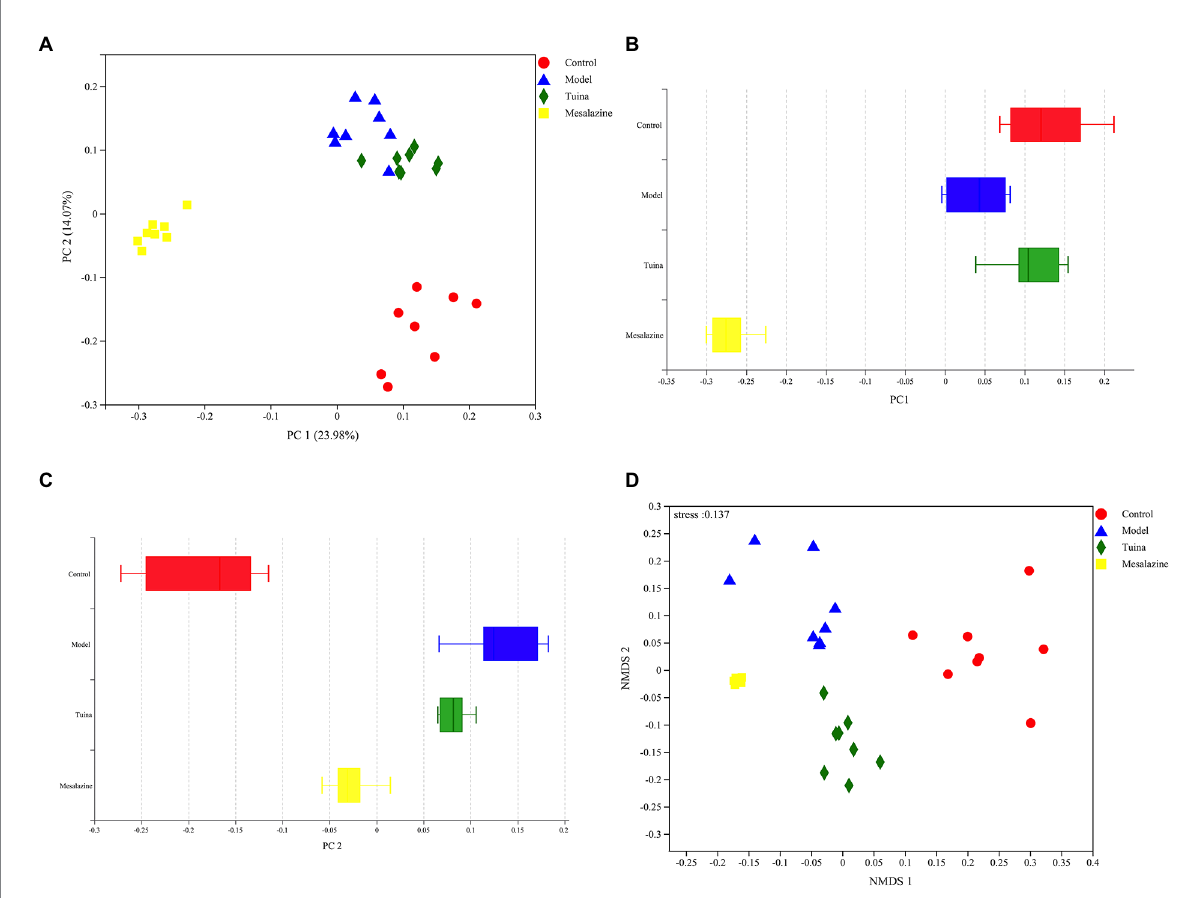
FIGURE 4 Beta diversity analysis of PCoA and NMDS. (A) PCoA between groups, the horizontal coordinate represents PC 1 and the vertical coordinate represents PC 2; (B) Distribution and dispersion of the groups on the PC 1 axis; (C) Distribution and dispersion of the groups on the PC 2 axis; (D) NMDS between